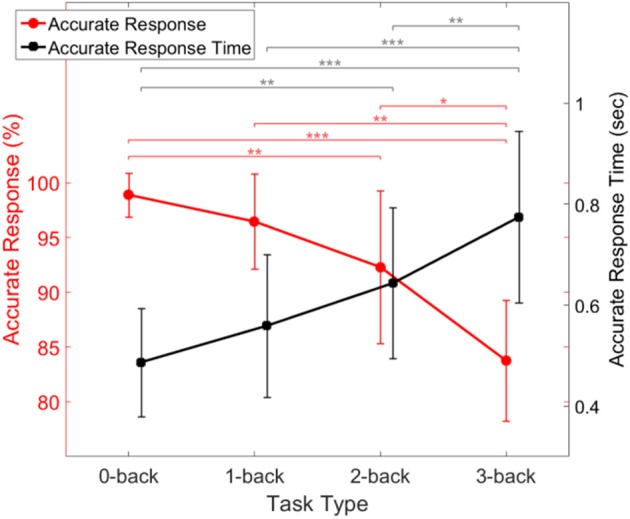
Behavioral performance of the subjects during task conditions of increasing difficulty, showing response accuracy (red) and response time (black). Error bars indicate the standard deviation of inter-subject variability. Asterisks indicate statistical significance derived from a two-way ANOVA comparison of each two response accuracy (red) or response time (black) (*p < 0.05, **p < 0.001, ***p < 0.0001).